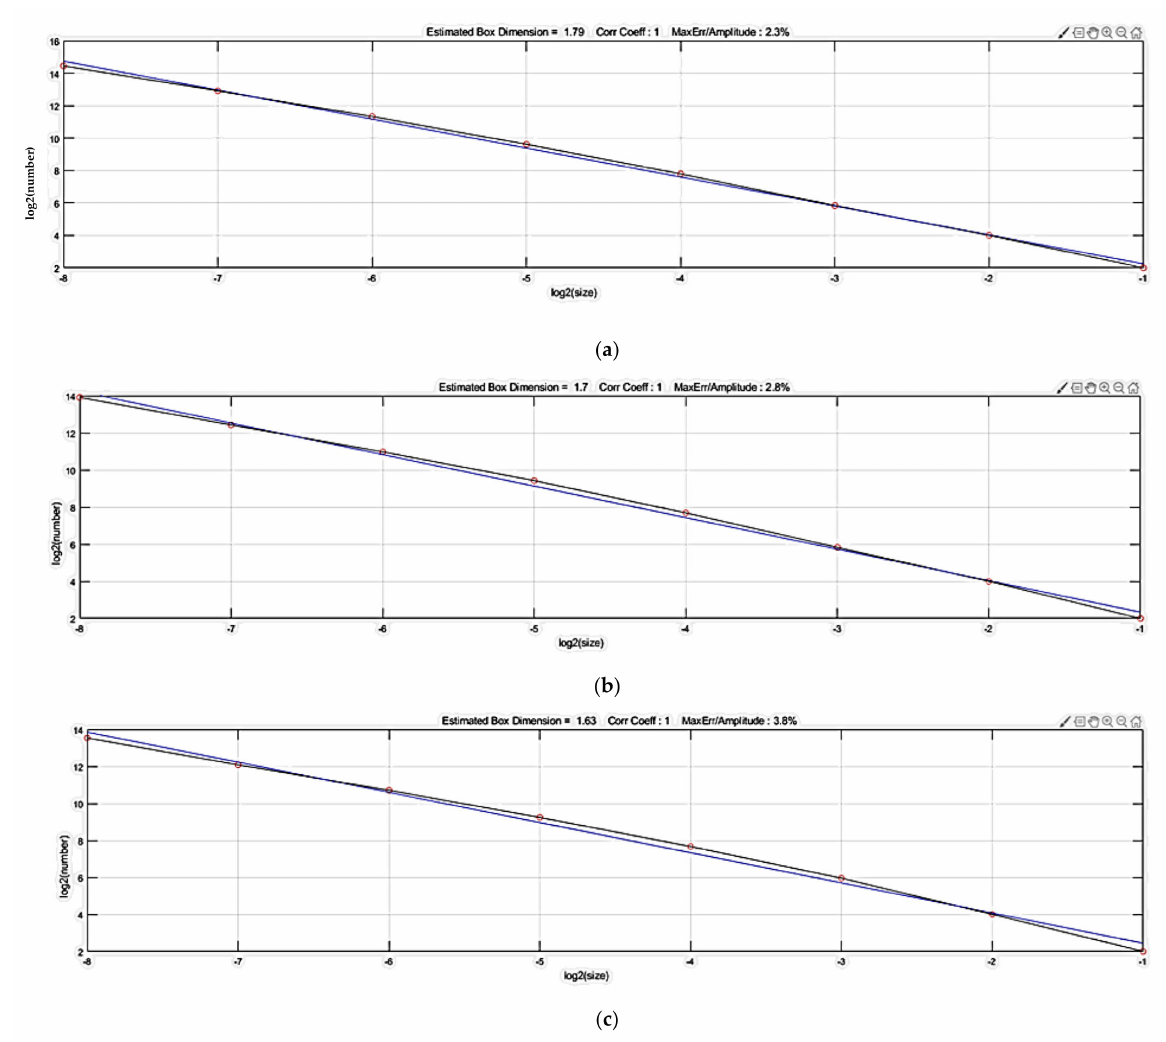
Figure 7. Calculation results of the box-counting dimension of the three rock fracture network diagrams ( a – c